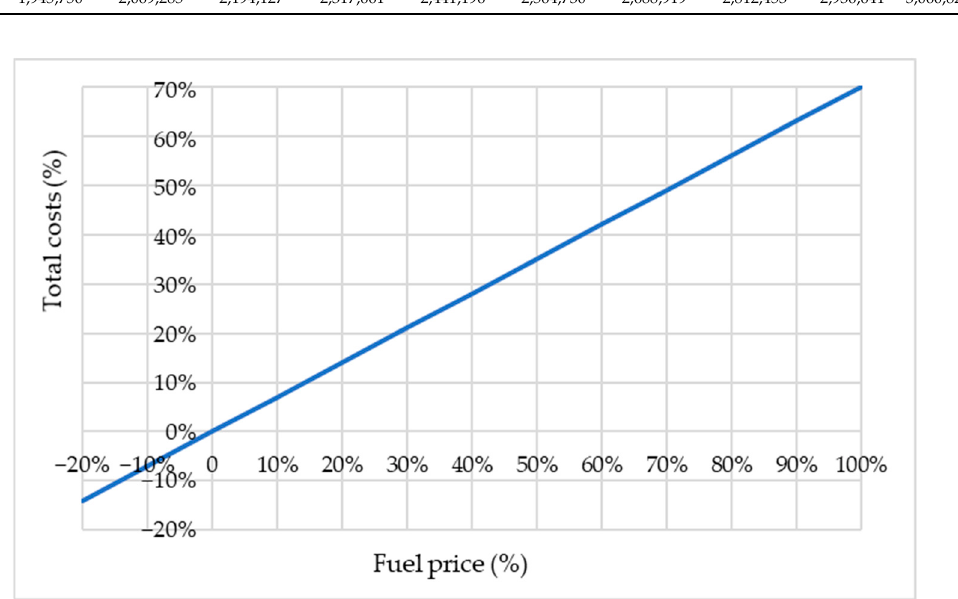
Figure 7. Sensitivity of total costs to the fuel price changes.